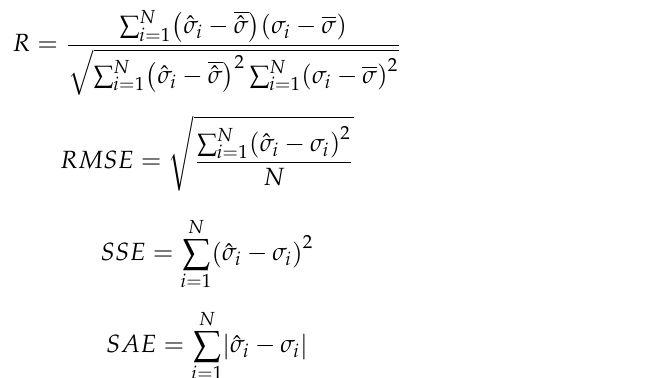
Figure 9. Comparison of prediction flow stress and experimental flow stress for the quadratic model: ( a ) 0.01 s − 1 ; ( b ) 0.1 s − 1 ; ( c ) 1 s − 1 ; ( d ) 10 s − 1 ; ( e ) 10 s − 1